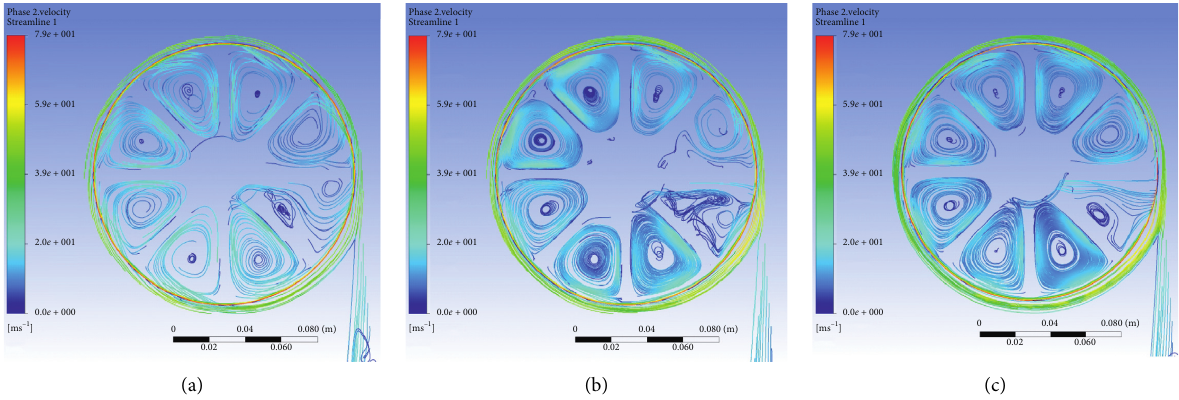
Figure 16: Gas streamline distribution with different gas concentrations. (a) C